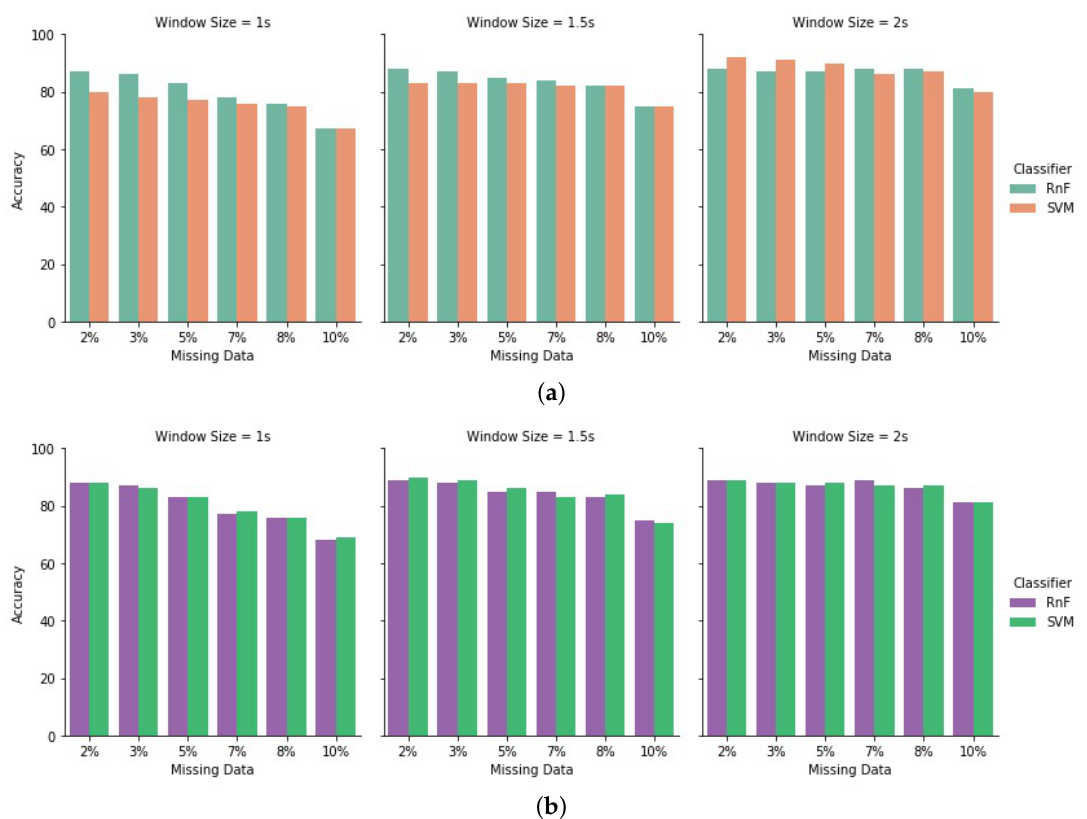
Figure 12. Evaluation of HASC dataset for window size of 1 s, 1.5 s, and 2 s; and missing percentage of 2%, 3%, 5%, 7%, 8%, and 10% in two scenarios: ( a ) HASC dataset on traditional approach; ( b ) HASC dataset on proposed